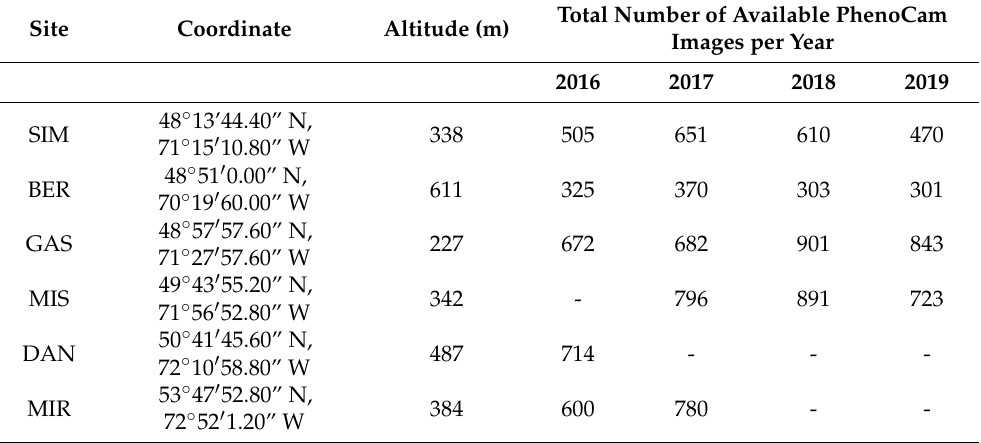
Table 1. Summary of PhenoCam site characteristics for Simoncouche (abbreviated as SIM), Gaspard (GAS), Bernatchez (BER), Mistassibi (MIS), Camp Daniel (DAN), and Mirage (MIR).